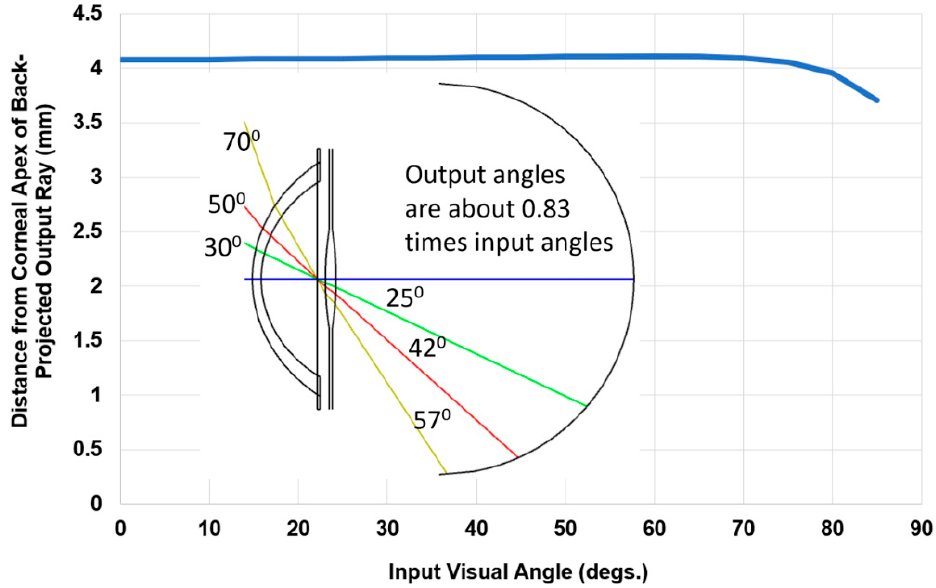
Figure 3. For a large range of input angles, output angles for chief rays come from approximately the axial exit pupil location, with angles that are about 0.83 times the input angles.